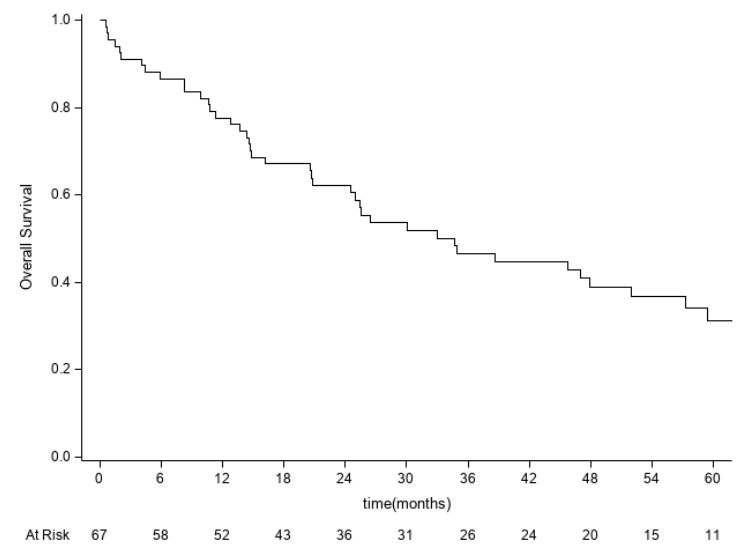
Figure 1. Kaplan–Meier overall survival Figure 1. Kaplan – Meier overall survival curve.